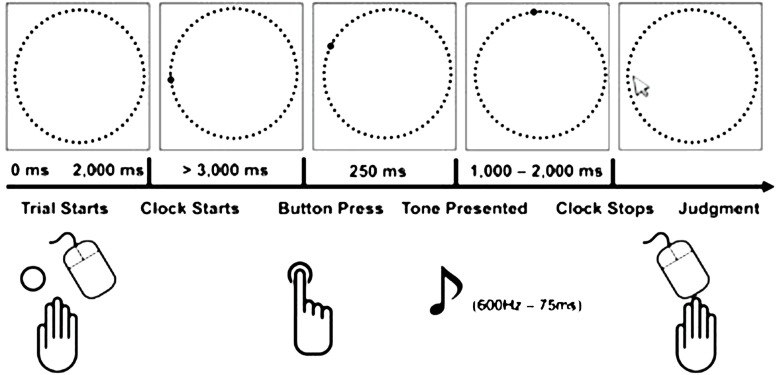
Illustration of the single-trial structure of the intentional binding task (adapted from Demanet et al., 2013).